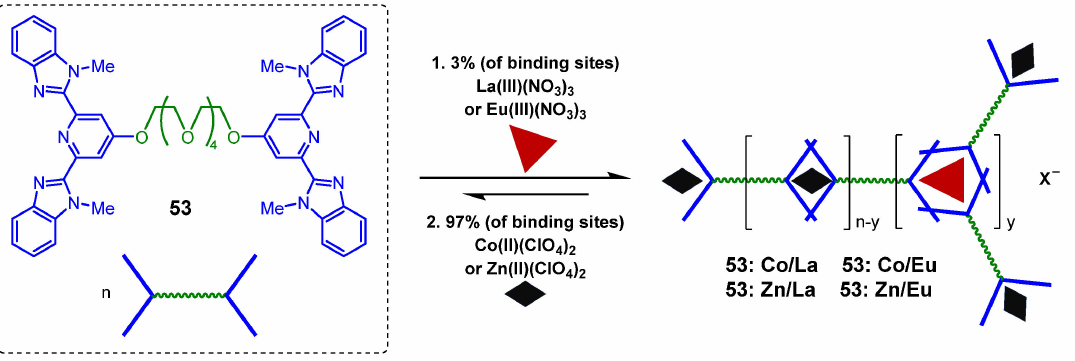
Figure 38. Schematic representation of the formation of a metallo-supramolecular gel-like material using a combination of lanthanoid and transition metal ions mixed with a monomer 53 .